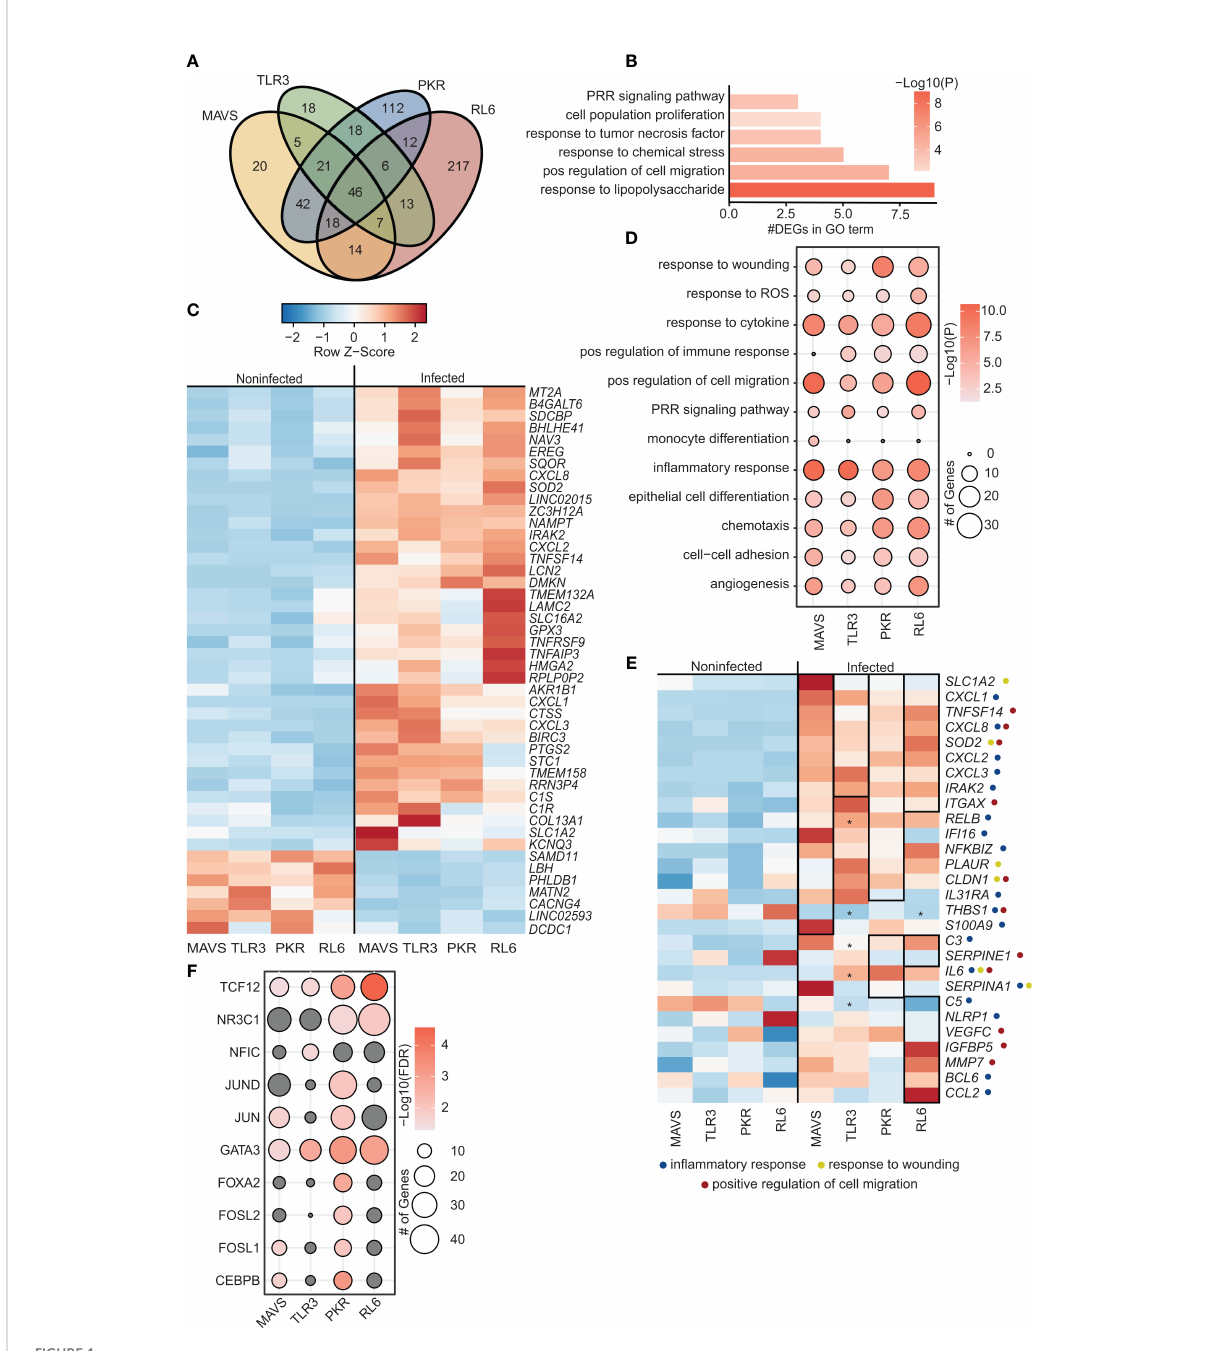
FIGURE 1 VZV-infected A549 lung cell lines lacking antiviral defense genes display distinct transcriptome characteristics. (A) Venn diagram of DEGs identi fi ed in siBRF1- VZV-infected cell lines relative to noninfected counterparts. (B) Bar graph depicting functional enrichment of the 46 DEGs common to all KO cell lines. Horizontal bars represent the number of DEGs enriching to each GO term. Colors are based on the GO terms with the lowest and highest – log(p-value) values. (C) Clustered heatmap comparing TPMs of the 46 DEGs common to all KO cell lines. Color range is based on scaled and centered TPM values. (D) Bubble plot representing functional enrichment of all DEGs in each KO cell line. Size of the bubble indicates the number of DEGs mapping to each GO term. Colors are based on the GO terms with the lowest and highest – log(p-value) values. (E) Clustered heatmap comparing TPMs of all DEGs in each KO cell line. Color range is based on scaled and centered TPM values. Box and * genes are differentially expressed in siBRF1- infected cell lines relative to noninfected counterparts. Symbol next to gene name represents GO terms the gene maps to. (F) Bubble plot representing transcription factors that are predicted to regulate the DEGs in each KO cell line. The size of the dot represents the number of genes, and the color represents – log(q-value) values. Analysis was performed using the Chea3 web